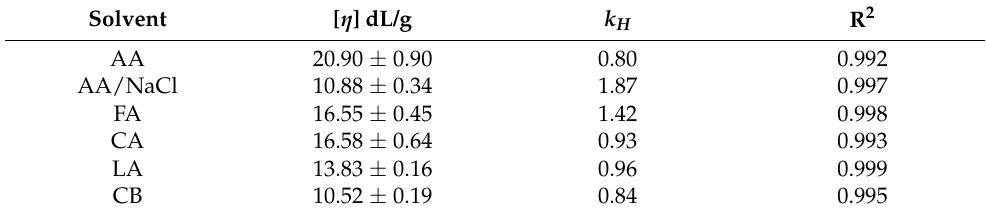
Figure 1. Reduced viscosity ( η sp /c) values of collagen solution in different solvents at 25 °C. Table 1. Values of intrinsic viscosity [ η ] and Huggins coefficient k H for collagen solutions in different solvents at 25 °C.